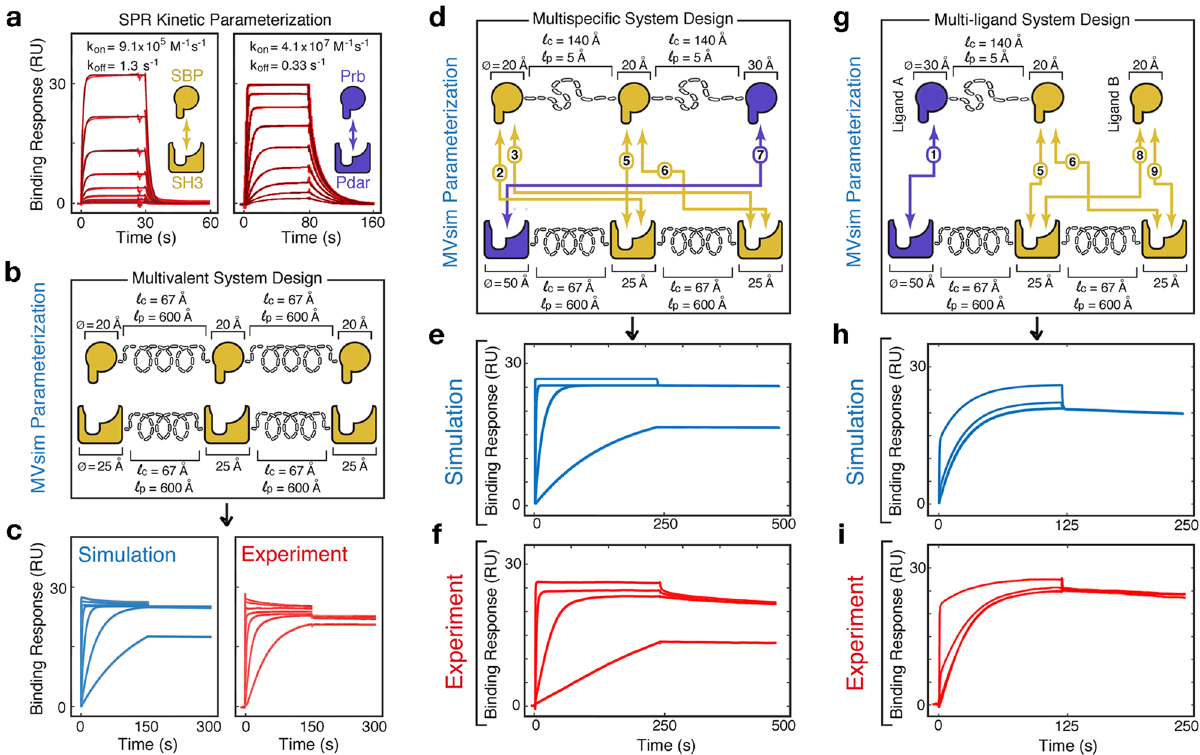
Fig. 3 | MVsim accurately simulates beads-on-a-string multivalent, multi- speci fi c, and multi-ligand interactions. a Monovalent SPR kinetic rate constants were experimentally determined for the SH3-binding peptide (SBP)-SH3 ( a , left panel) and Prb-Pdar ( a , right panel) interactions that were used to build the mul- tivalentsystems.Kinetic fi tswitha “ rapidmixing ” 1:1Langmuirmodelshowedgood agreement since the experimental conditions were not signi fi cantly mass-transfer limited (see Supplementary Experimental Methods). b A trivalent, monospeci fi c receptor – ligandinteractionwasengineeredandparameterizedwithin MVsim using values for the kinetic rate constants of association ( k on ) and dissociation ( k off ), domain diameters (Ø), and contour ( l c ) and persistence ( l p ) lengths for the linkers. c Simulated ( c , left panel) and experimental ( c , right panel) binding response dynamicsforthetrivalent,monospeci fi cinteractionatsevenligandconcentrations (0.98, 3.9, 15.6, 62.5, 250, 1000, and 2000nM). Model-experiment RMSE is 2.1 RU. d A trivalent, bispeci fi c receptor – ligand interaction was engineered and para- meterized using values for the kinetic rate constants of association ( k on ) and